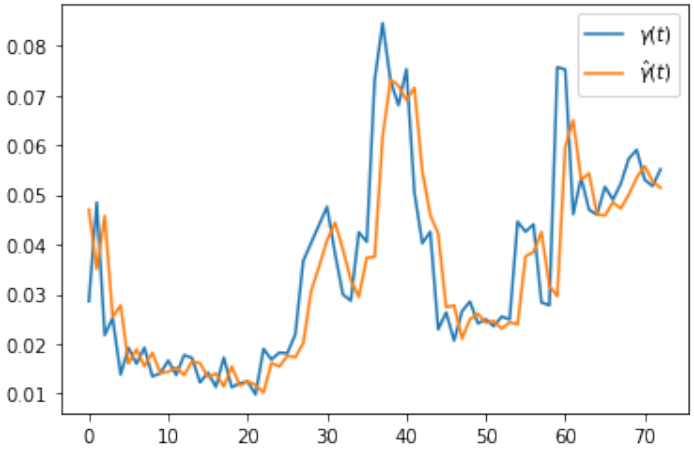
Figure 3. γ rates during the given period.